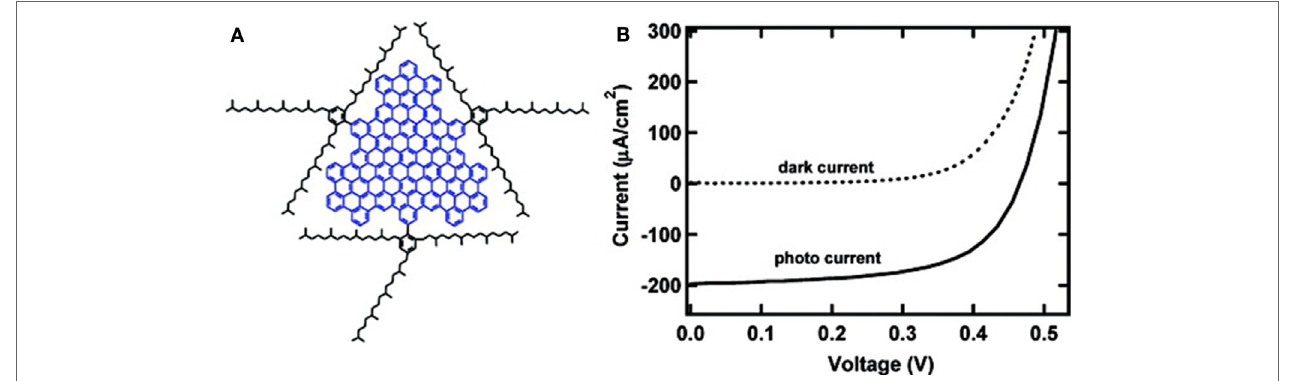
FiGURe 9 | (A) Molecular structure of GQD. The graphene moiety is marked blue and the three solubilizing groups are black. (B) The current − voltage characteristics in the dark and under illumination, respectively (Yan et al., 2010). Copyright ACS Publications, 2010.